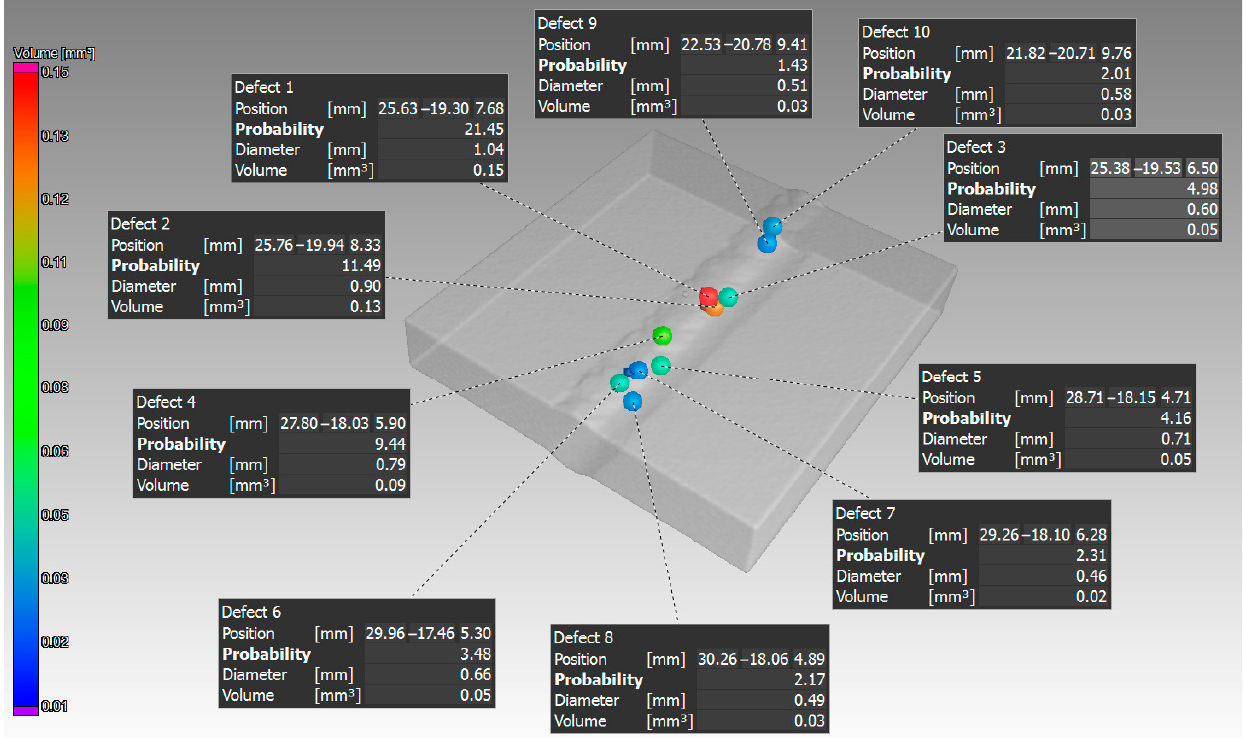
Figure 11. Computed tomography of weld joint no. 2 created at filler wire feed of 70 cm/min.